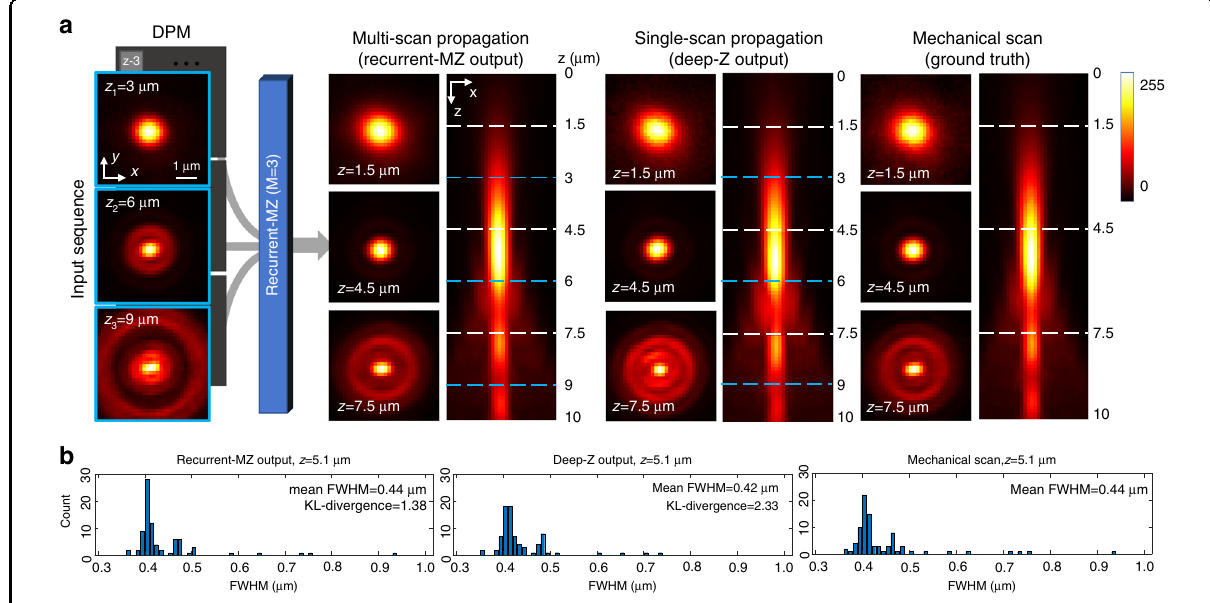
Fig. 3 The performance of Recurrent-MZ using fl uorescence nanobeads. a Volumetric imaging using Recurrent-MZ ( M = 3) and Deep-Z on 50 nm fl uorescence nanobeads. There are 3 input images for Recurrent-MZ ( M = 3) and to provide a fair comparison, Deep-Z always takes in the nearest input image among these 3 inputs to infer another axial plane. The PSFs generated by Recurrent-MZ, Deep-Z and mechanical scanning ( Δ z = 0.1 μ m) are shown for comparison. b FWHM histograms for 88 individual isolated fl uorescence nanobeads at z = 5.1 μ m, measured from mechanical scanning (101 axial images), Deep-Z reconstruction and Recurrent-MZ reconstruction ( M = 3). Also see Video